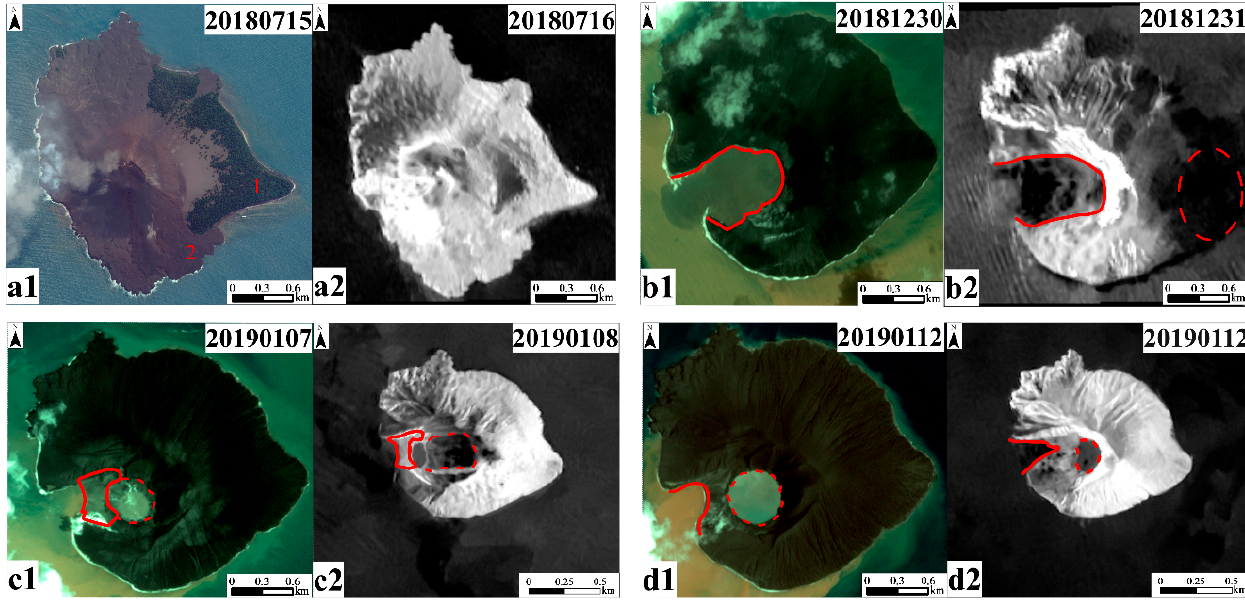
Figure 8. Comparison of optical and SAR images at the same time; optical images for a1, b1, c1, d1; SAR images for a2, b2, c2, d2.